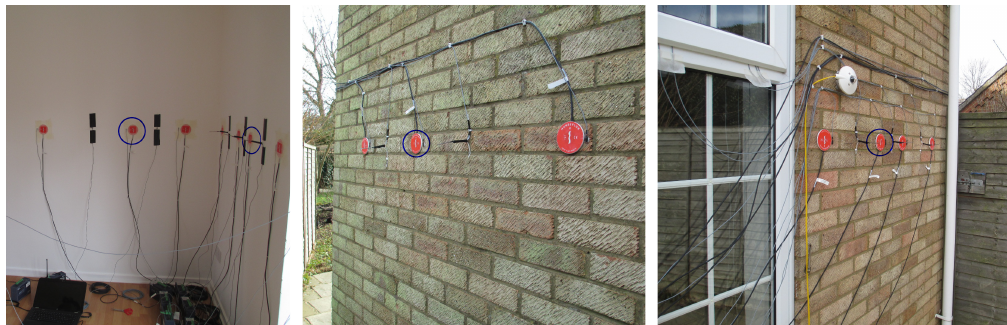
Figure 4. Internal ( left ) view of the north- and east-facing walls (with the north-facing one on the left side of the corner), external north-facing wall ( middle ), and external east-facing wall ( right ) for the cavity wall (CWall) case study. The pair of sensors analysed are circled in